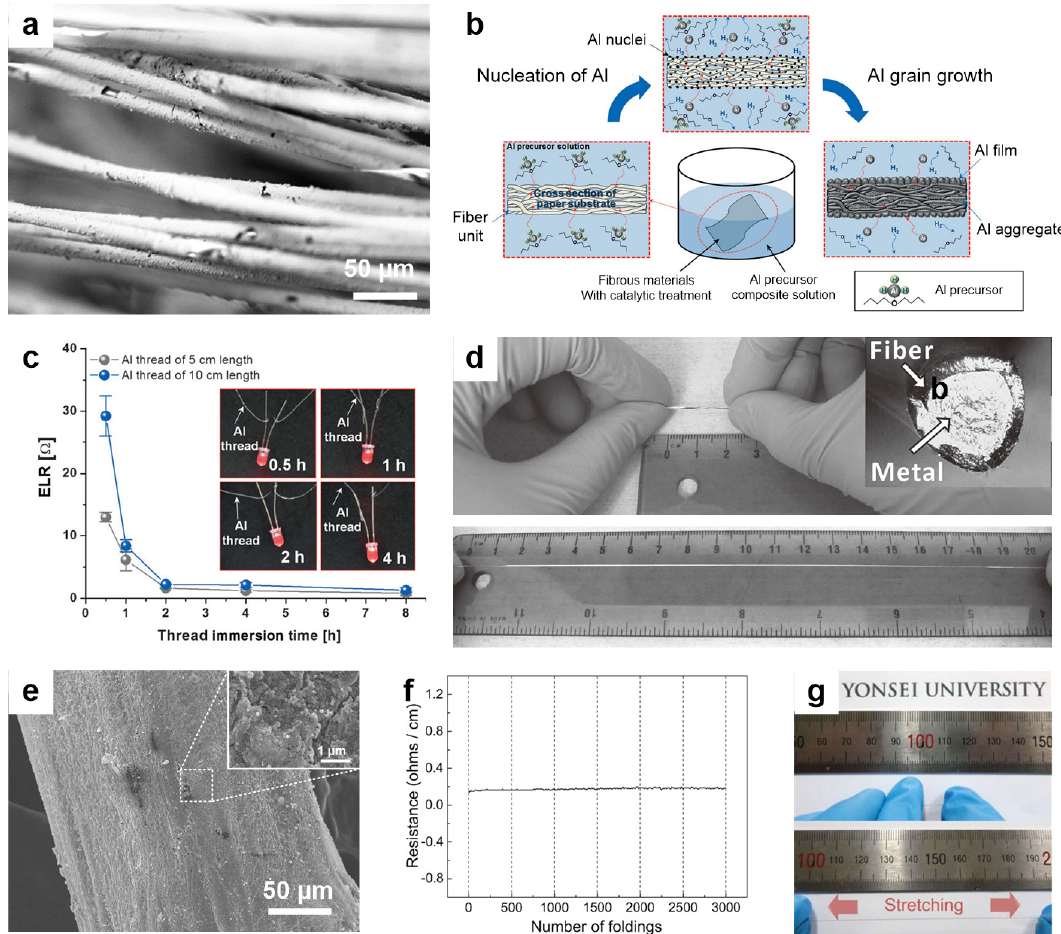
Figure 4. ( a ) SEM image of conductive Kevlar fibers coated with Ni/Au; ( b ) Schematic representation of the chemical solution process for the fabrication of conductive Al textiles; ( c ) Plot of the electrical linear resistance of Al-based conductive fiber synthesized by the chemical solution process and inset shows the functioning LEDs; ( d ) Optical image of unstretched and stretched (up to 20 cm) conductive fiber; ( e ) SEM image